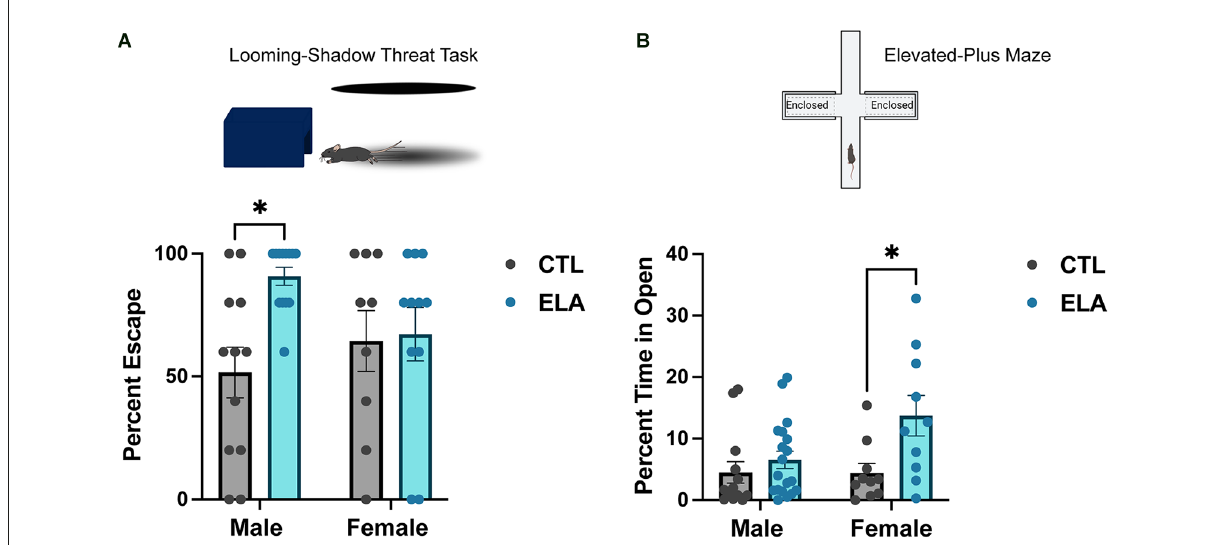
FIGURE1 Sex-specific behavioral outcomes of early-life adversity. (A) ELA provokes an increased escape response to a looming-shadow threat in male, but not female, adult mice (trend for ELA x Sex interaction; F (1,41) = 3.71, p = 0.06; post-hoc test, p < 0.05). (B) On the other hand, ELA increases risk-taking behavior, as measured by an increased percent time spent in the open arms in the elevated-plus maze, in female, but not male, adult mice (trend for ELA x Sex interaction; F (1,48) = 3.31, p = 0.08; post-hoc test, p < 0.05). Figure created with BioRender.com. Data are mean ± SEM; p ≤ 0.1 criteria used for interaction terms to trigger subdivision for lower-order tests; ∗ p < 0.05 post-hoc